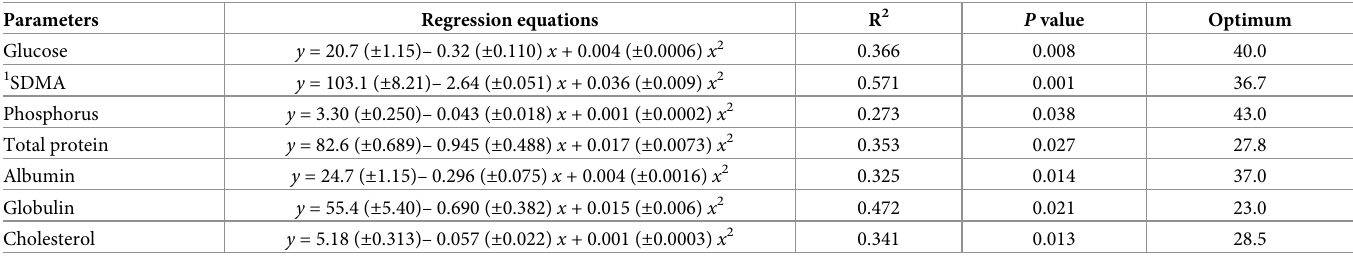
Table 4. Responses of serum biochemical parameters in Hy-Line Silver Brown cockerels fed diets containing incremental levels of red grape pomace. Parameters Regression equations